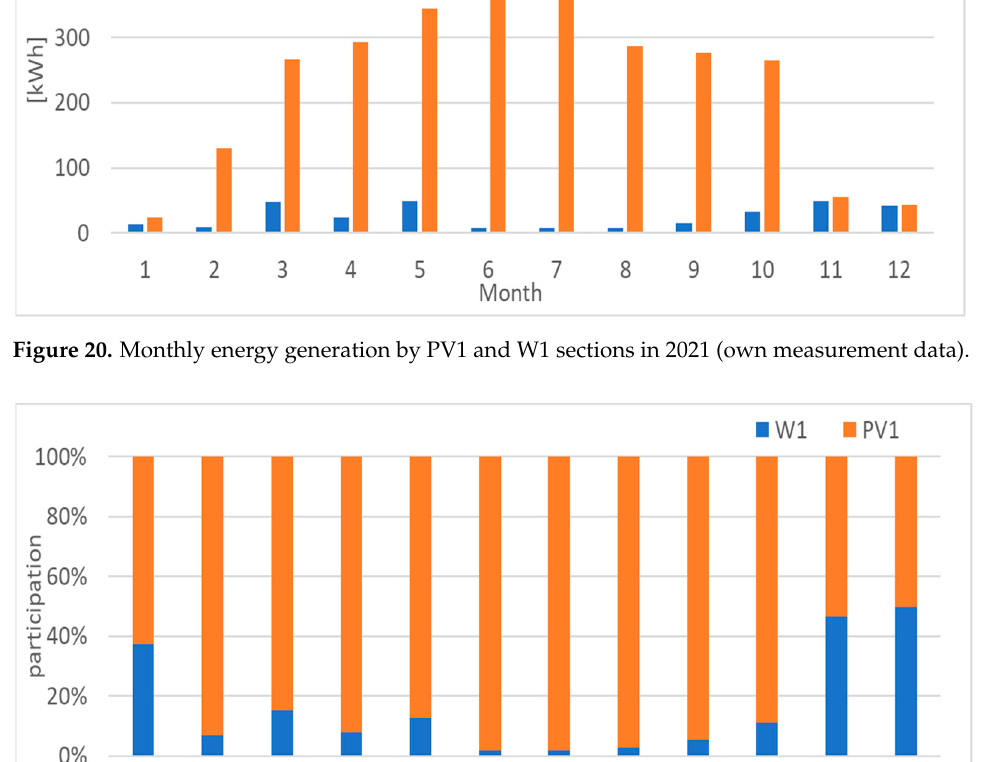
Figure 21. Share of PV1 and W1 sections in monthly generation of PV1 and W1 sections in 2021 (own measurement data).